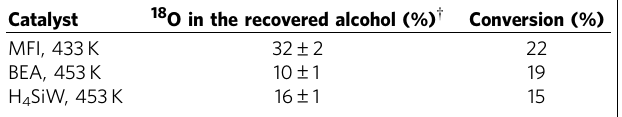
Table 2 | The 18 O exchange during aqueous-phase cyclohexanol